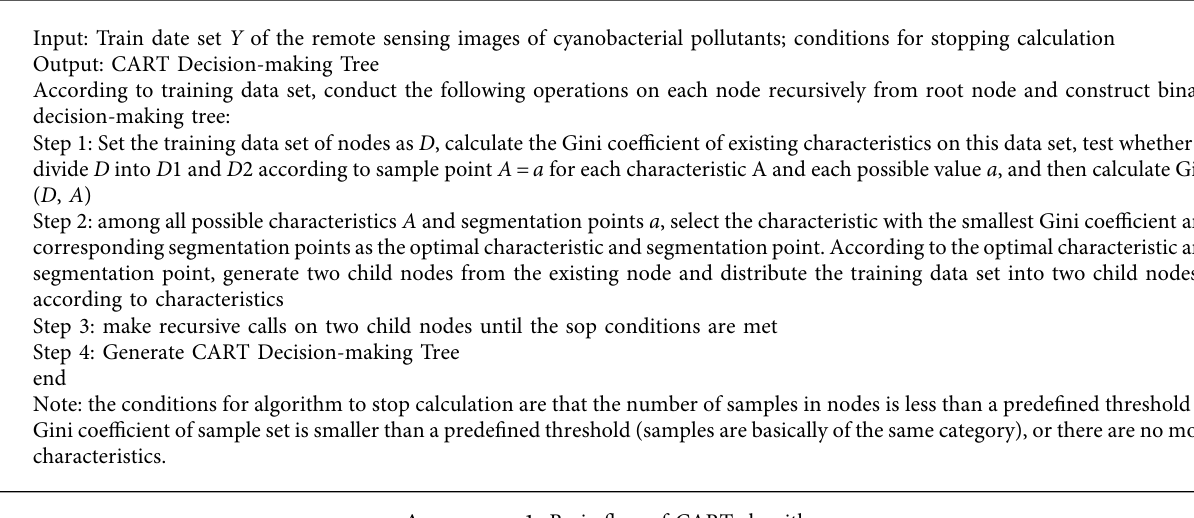
A LGORITHM 1: Basic flow of CART algorithm.